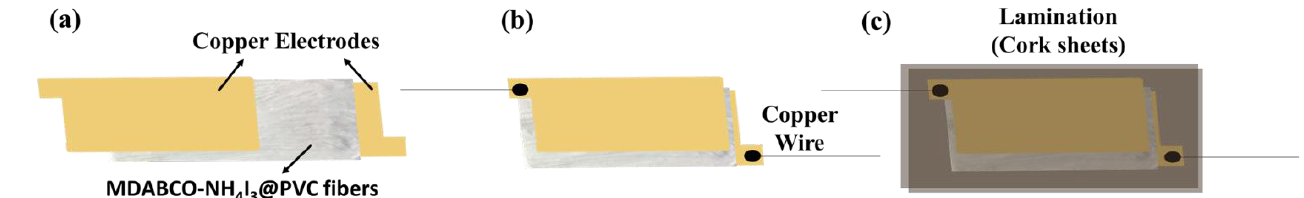
Figure 3. Schematic of MDABCO-NH 4 I 3 @PVC. ( a ) Electrospun nanofiber mat sandwiched between two copper electrodes. ( b ) Wires attached to the electrodes. ( c ) The complete laminated system with thin cork